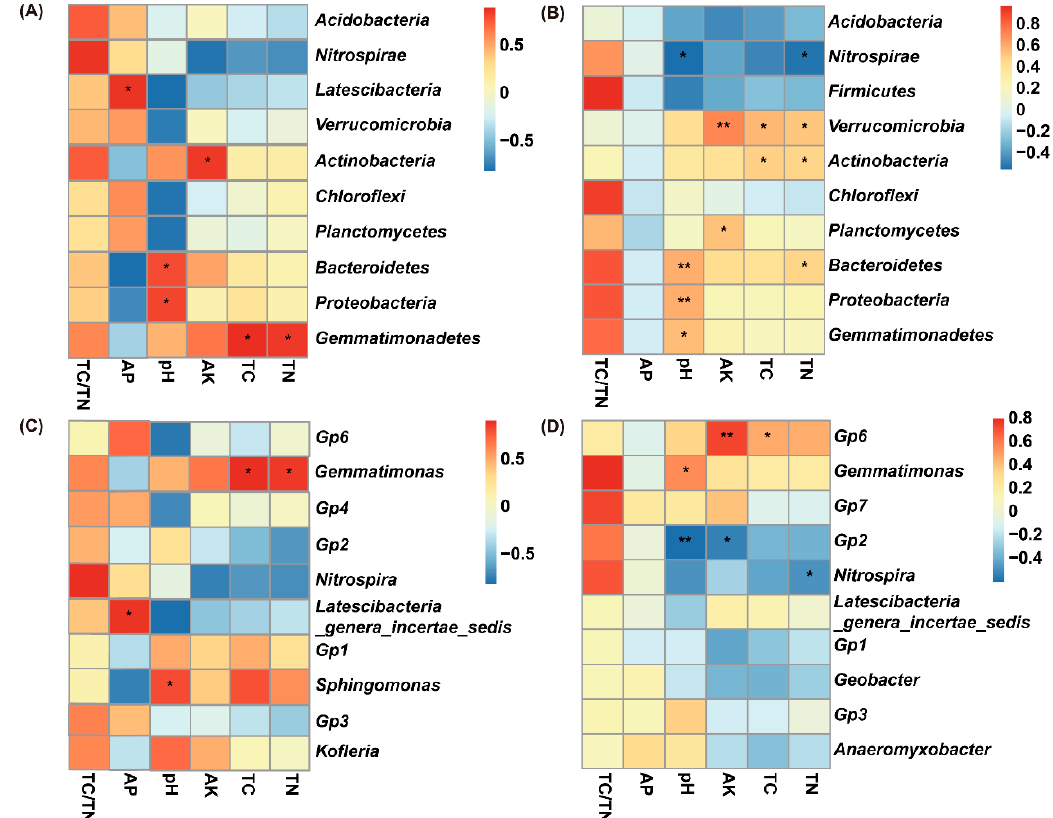
Figure 8. Pearson correlation coefficients for soil physiochemical properties and the most abundant bacterial phyla at 0–10-cm ( A ) and 10–40-cm ( B ) depths. Pearson correlation coefficients for soil physiochemical properties and most abundant bacterial genera at 0–10-cm ( C ) and 10–40-cm ( D ) depths. The heatmap cells marked by “*” or “**” are statistically significant: * p < 0.05 and ** p < 0.01.